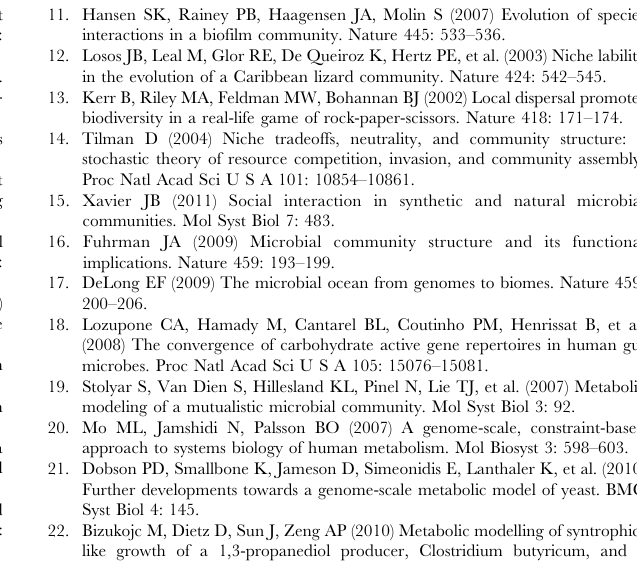
Table S1 Updated model of D. vulgaris and details of the model corrections. Text S1 Optimization formulation and solution procedure for OptCom and details of the update procedure for the metabolic model of D. vulgaris